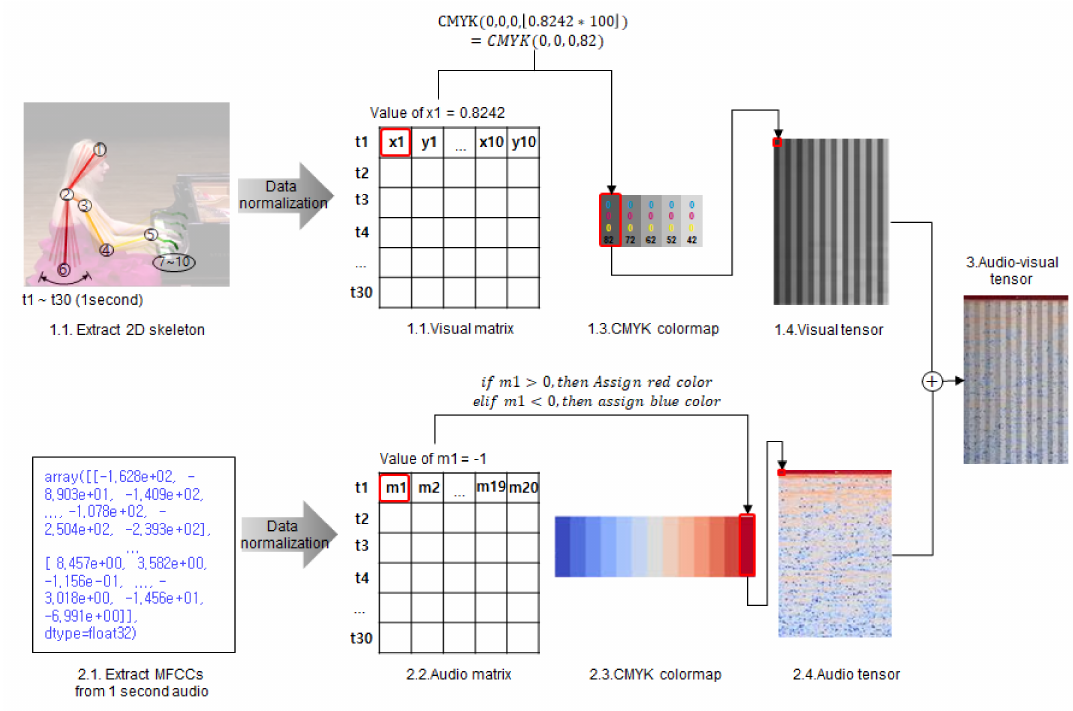
Figure 6. Construction process of audio-visual tensor in